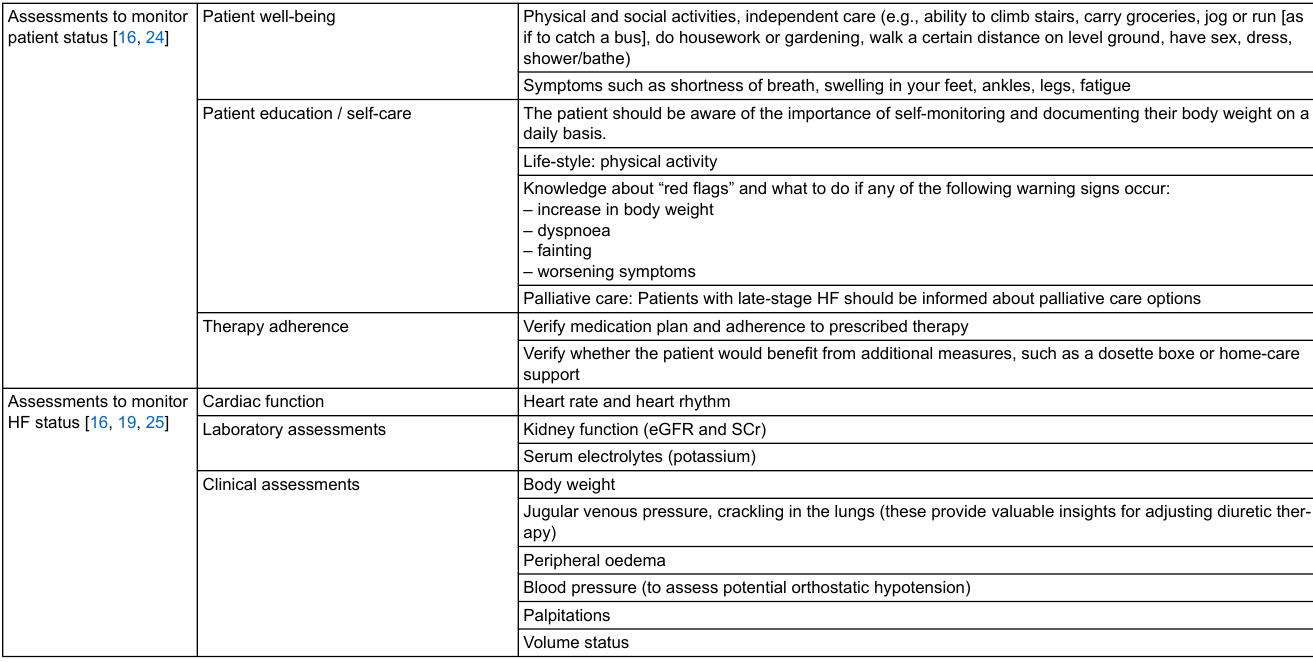
Table 1: Assessments in primary care for monitoring HF patient status. Assessments to monitor patient status [16,